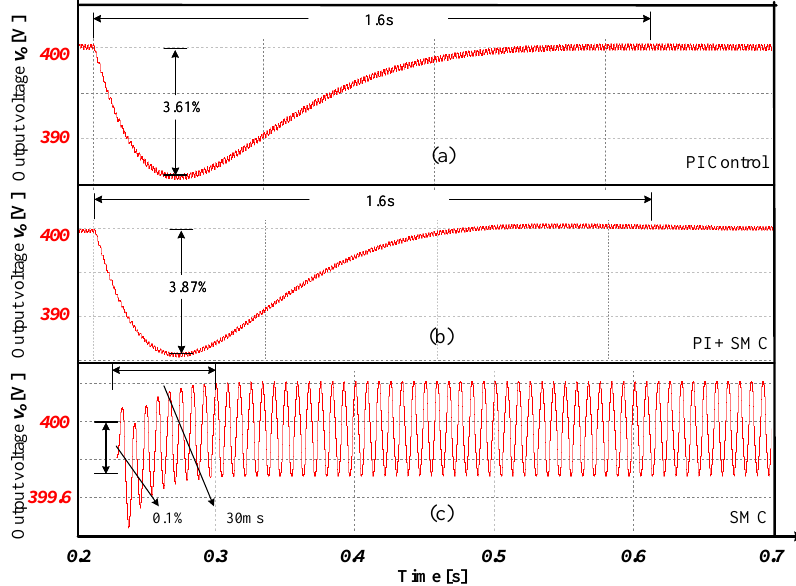
Figure 10. DC voltage transient response when load increases from 250 W to 500 W, comparing the performance of ( a ) PI control; ( b ) PI-SMC; and ( c )